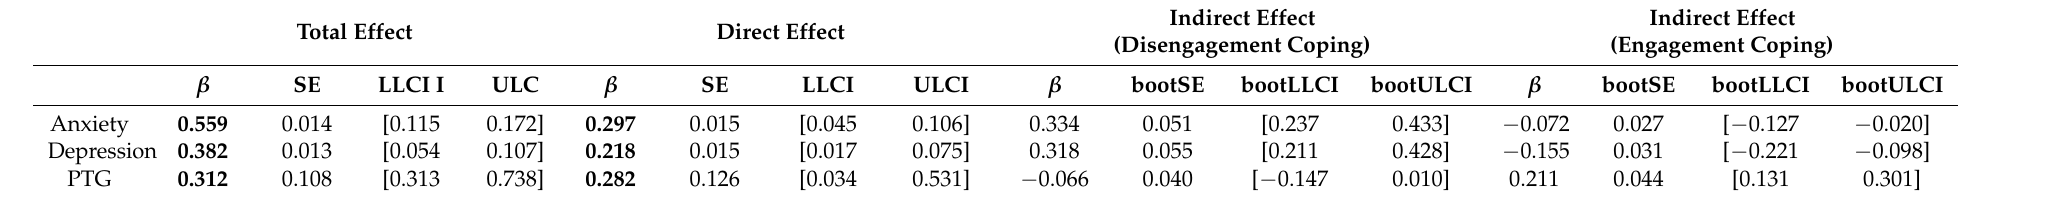
Table 2. Estimated standardized coefficients for the mediation model of Disengagement and Engagement coping